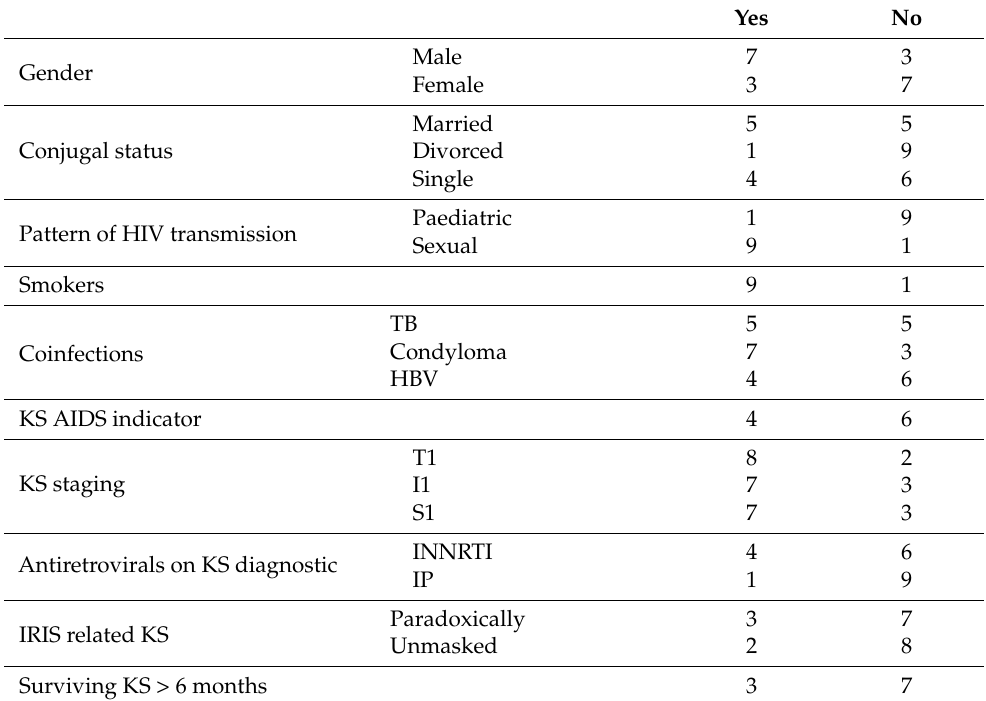
Table 2. Characteristics of the 10 patients with HIV and Kaposi’s